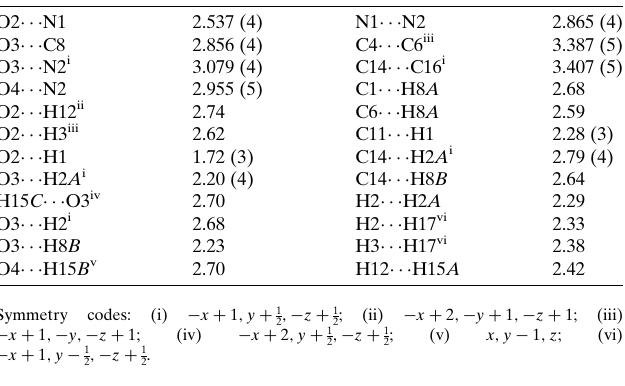
Table 2 Selected interatomic distances (A˚